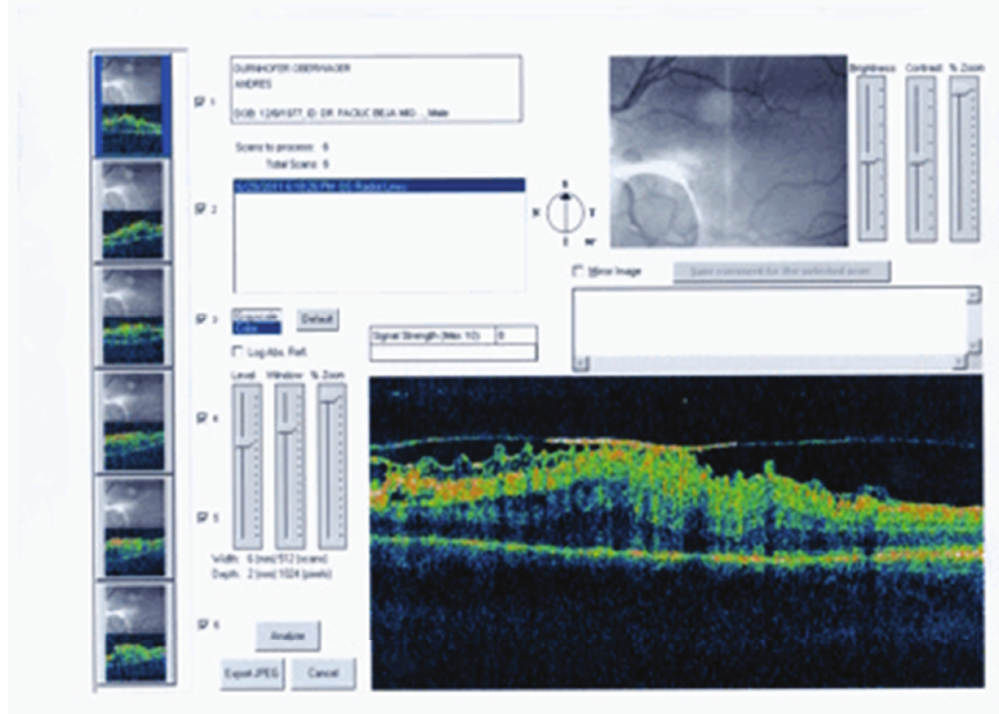
Figure 2: Time domain optical coherence tomography from the left eye shows a complete distortion of the internal and external architecture of the retina, being nasal and inferior to the fovea. There is a highly reflective membrane over the retina tissue, which makes contact with the retina in the central part of the projection. The nerve fiber layer shows a characteristic “Saw” configuration. There is a substantial increase in the retinal